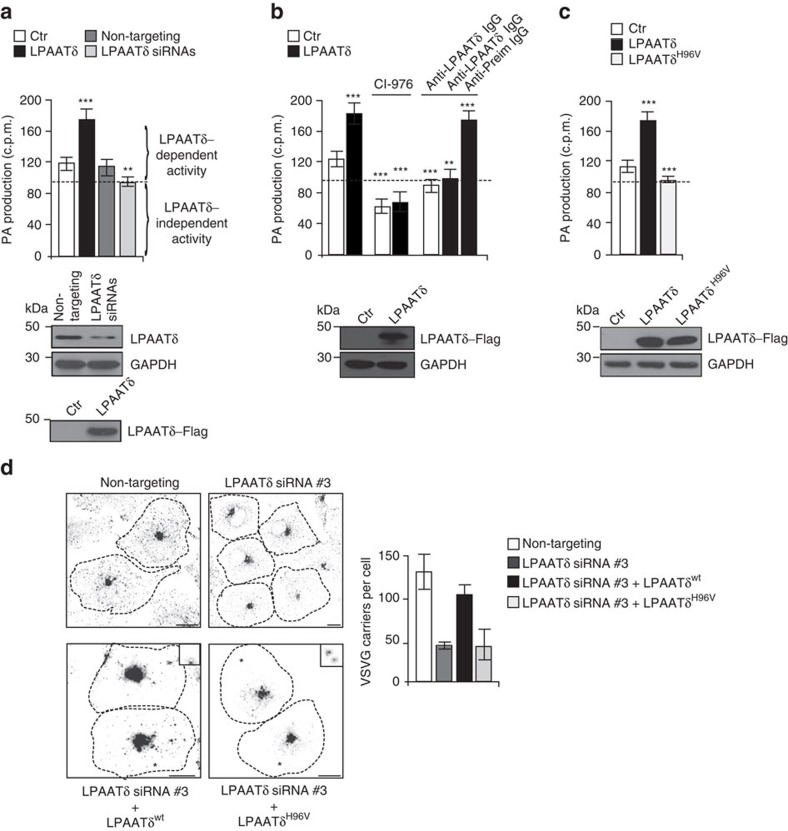
LPAATδ is a canonical LPAAT and its activity is required for post-Golgi carrier formation.(a) Quantification of phosphatidic acid (PA) production in the LPAAT assay for post-nuclear supernatants from HeLa cells transfected for 48 h with an empty Flag-vector (Ctr) or with LPAATδ–Flag (LPAATδ), or for 72 h with non-targeting or LPAATδ siRNAs. The curly brackets indicate the LPAATδ-dependent and independent activities, as defined in Methods. (b) Quantification as in a, with the post-nuclear fractions also incubated with 50 μM CI-976, or polyclonal anti-LPAATδ antibody (anti-LPAATδ IgG), or anti-preimmune-IgG (anti-Preim-IgG; as control) for 30 min at 25 °C before LPAAT assay. (c) Quantification as in a, also in parallel with the LPAATδH96V–Flag (LPAATδH96V) catalytically inactive mutant. (a–c) The dashed line indicates the level of endogenous LPAAT activity not associated with LPAATδ (see text for details). Bottom: representative western blotting with an anti-Flag antibody, for the transfection efficiencies of these proteins used for the LPAAT assays. Glyceraldehyde 3-phosphate dehydrogenase (GAPDH) is shown for the internal protein levels. Molecular weight standards (kDa) in a–c, are indicated on the left of each panel. (d) Representative images of COS7 cells transfected with non-targeting or LPAATδ siRNA (duplex #3; LPAATδ siRNA #3), and with LPAATδwt–Flag or the LPAATδH96V–Flag catalytically inactive mutant, and subjected to VSV infection and the TGN-exit assay with 0.5% tannic acid. The cells were fixed 30 min after the shift to the permissive temperature (32 °C) and processed for immunofluorescence with monoclonal anti-Flag and polyclonal anti-VSVG (p5D4) antibodies, to monitor formation of VSVG-containing carriers. Dotted lines show cell borders. Asterisks represent LPAATδwt–Flag and LPAATδH96V–Flag transfected cells (see inserts for staining with anti-Flag antibody; bottom images). Scale bars, 10 μm. Quantification of VSVG-positive carriers (right). Data are means±s.d. of three independent experiments. **P<0.01, ***P<0.005 versus control (Student's t-tests).